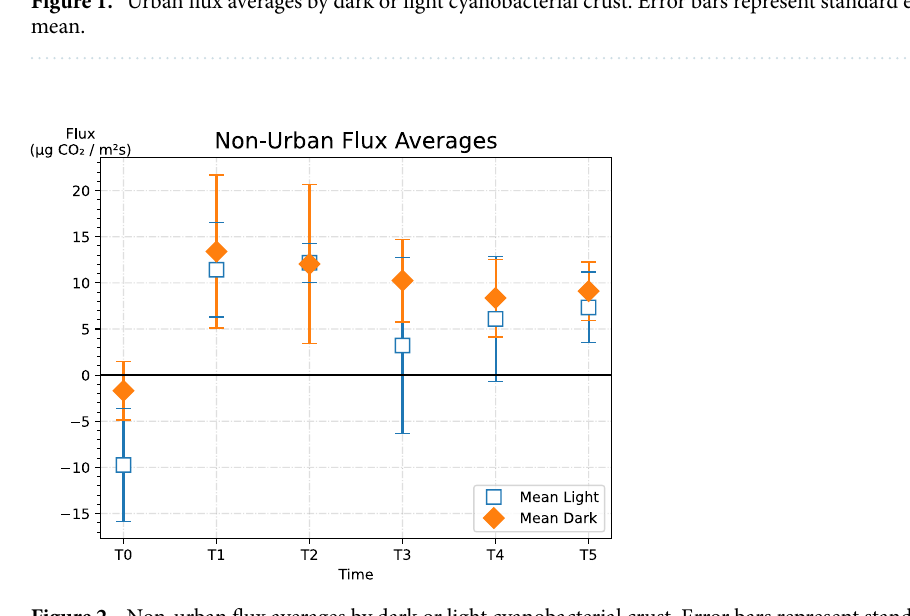
Figure 2. Non-urban flux averages by dark or light cyanobacterial crust. Error bars represent standard error of the